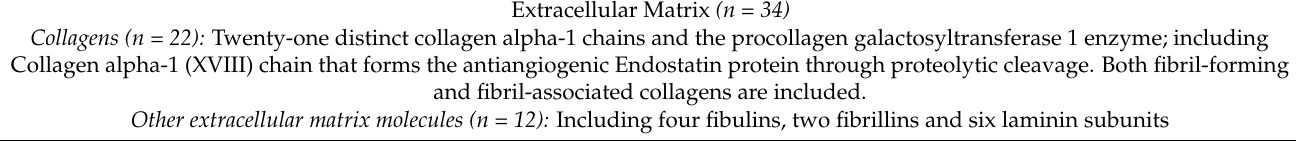
Table 2. The diversity of extracellular protein release by MSCs and osteoblasts during in vitro culture; a summary of protein classes showing at least five identified members. For more details see Table S1. Extracellular Matrix (n =